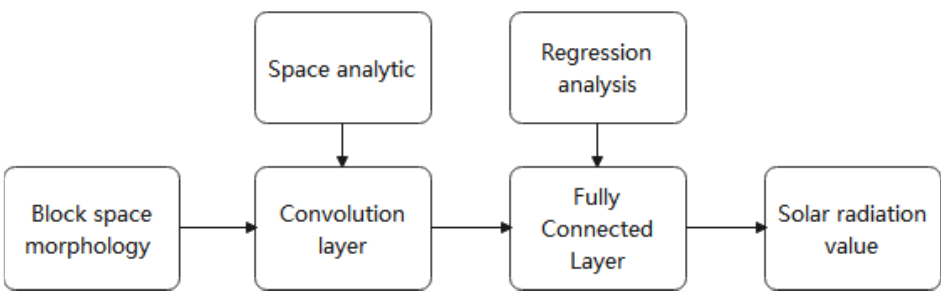
Figure 14. Schematic diagram of neural network prediction principle